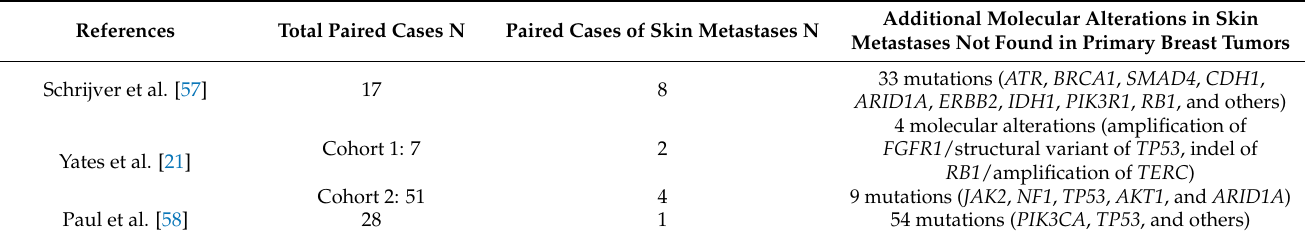
Table 2. Additional mutations in skin metastases vs. primary breast tumors in paired cases along with data source.